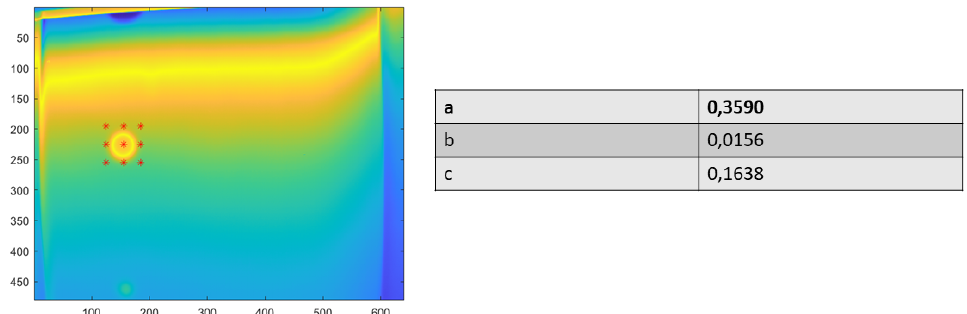
Figure 11. Calculation of the contrast between 9 pixels. The centre pixel is situated in the middle of the defect and the other defects are spaced equally around the centre pixel. The distance between the pixels is 30 pixels. The contrast values are calculated for the images (a–c) of Figure 9. A higher value equals a bigger contrast between the defect and the